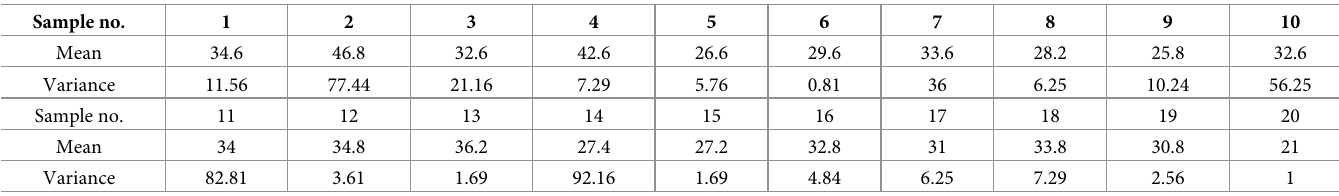
Table 6. Real life data-1 (Summary statistics of 20 samples each containing 5 surface roughness measurement on reamed hole (in)). Sample